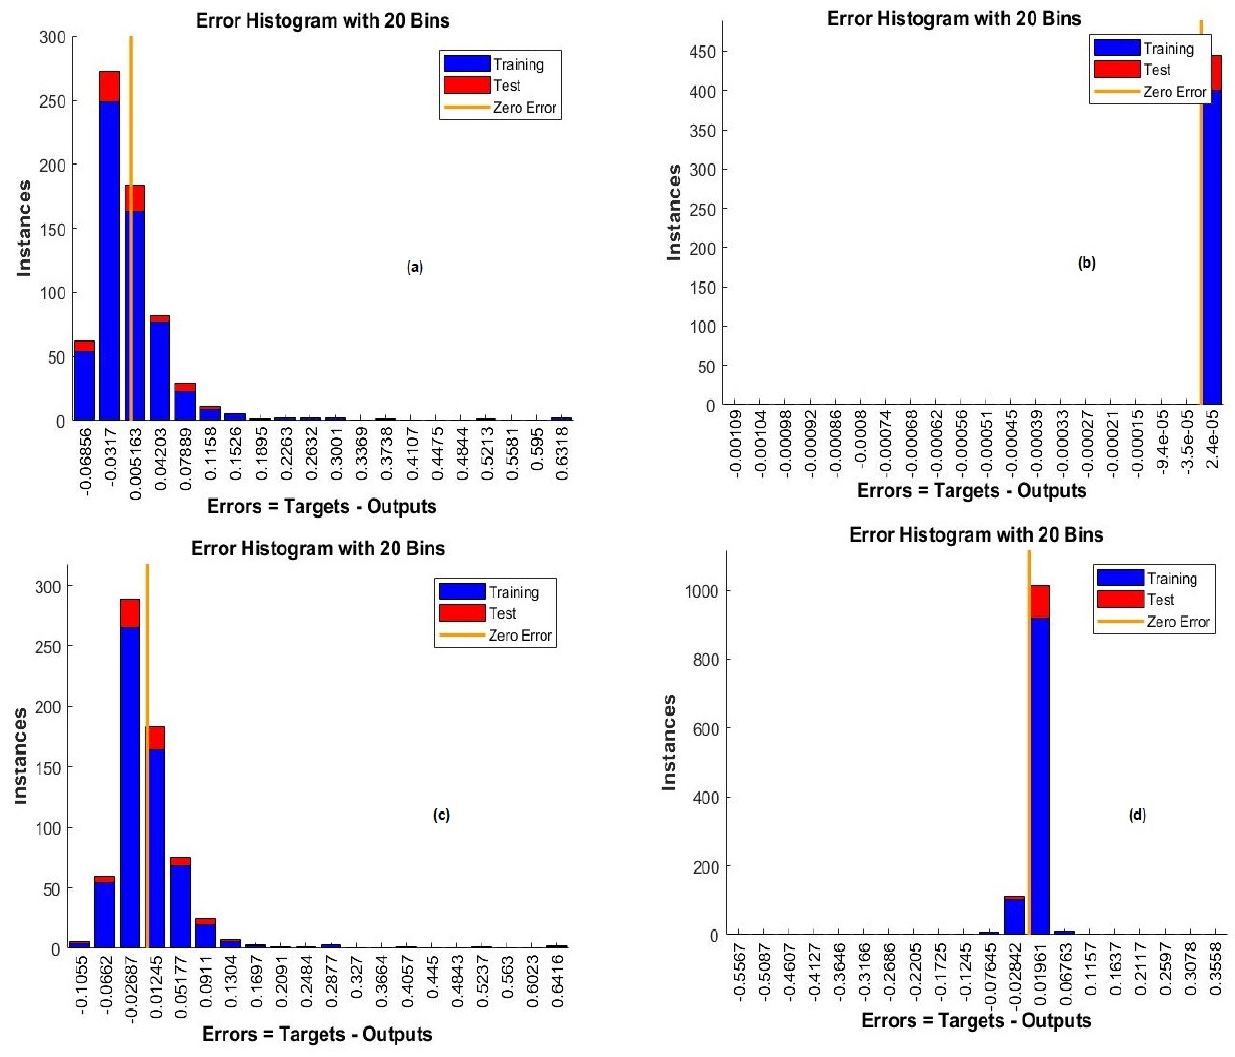
Figure 4. Histogram error of ANN model: ( a ) Riyadh, ( b ) Dammam, ( c ) Jeddah, and ( d ) Al-Khobar.